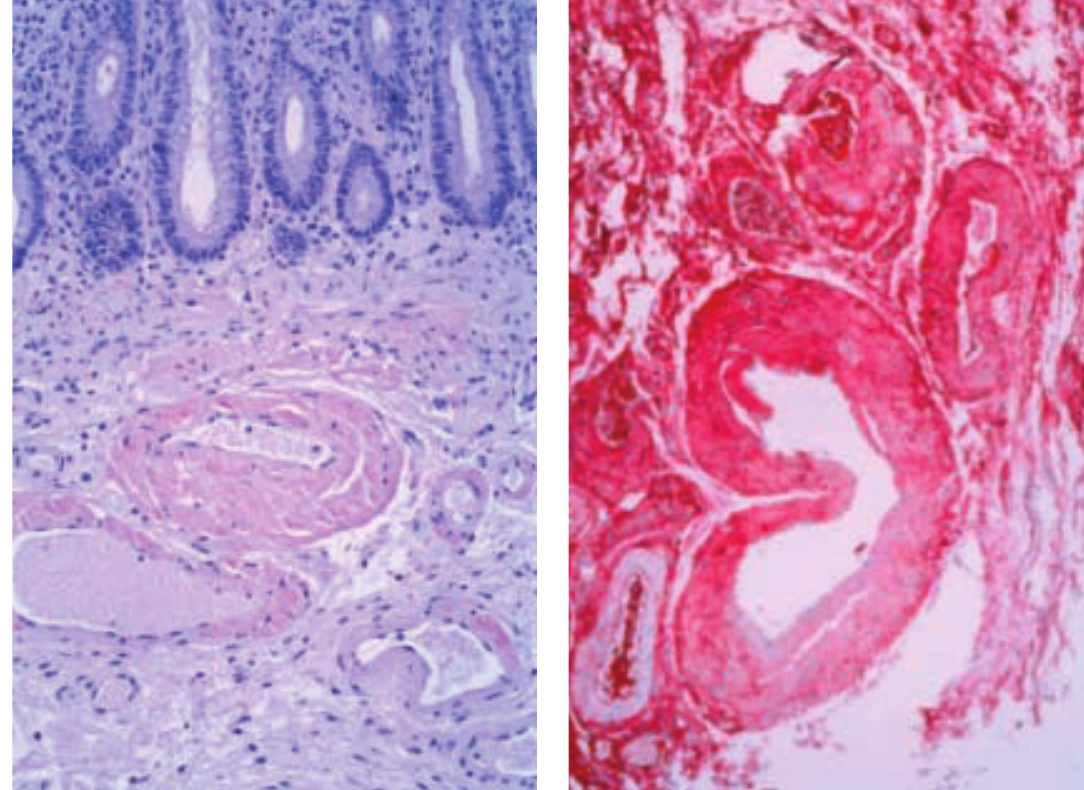
Figure 3 Congo red staining showing massive perivascular amyloid deposition.